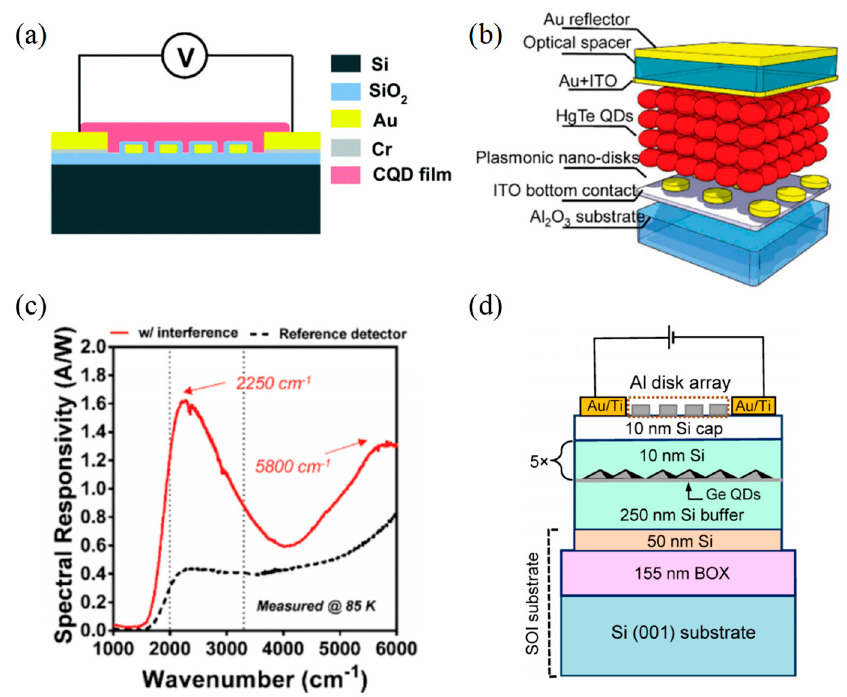
Figure 12. Structures and performance characterization of 0D materials − based infrared PDs with nanoarray structures. ( a ) Schematic configuration of HgSe QDs − based infrared PD with plasmonic Au structures [91]. Copyright 2017, J Mater Chem C Mater . ( b ) Schematic illustration of the HgTe CQD detector with interference structure + plasmonic disk array. ( c ) Measured spectral responsivity of HgTe CQDs with interference-enhanced plasmonic disk array [92]. Copyright 2018, ACS Nano . ( d ) Layer sequence of the five-period Ge/Si-on-SiO 2 lateral QDPs [93]. Copyright 2020, Journal of